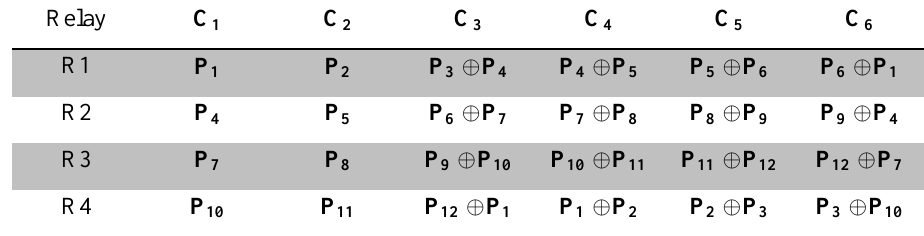
Figure 4. The packet coding schema used in Marinkovic and Popovici’s (MP’s) mechanism.